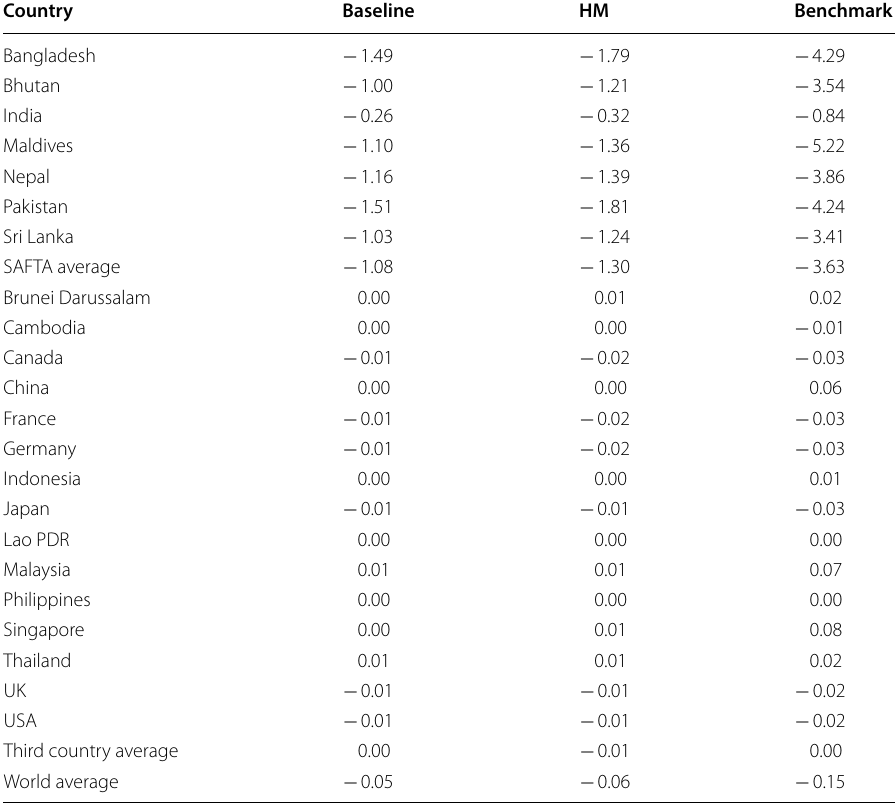
Table 5 Conditional GE effect of SAFTA, measures from the changes in real GDP. Source Authors’